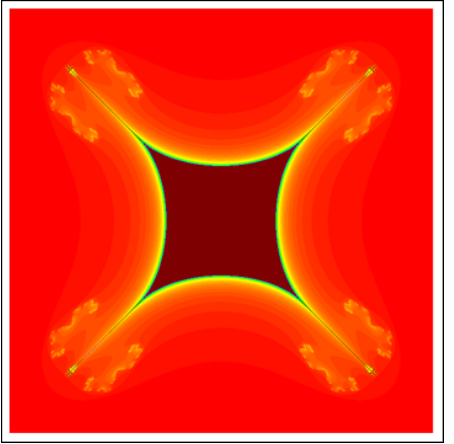
Figure 51. Multi-corn via F-iteration with image visual time = 45.7 s.